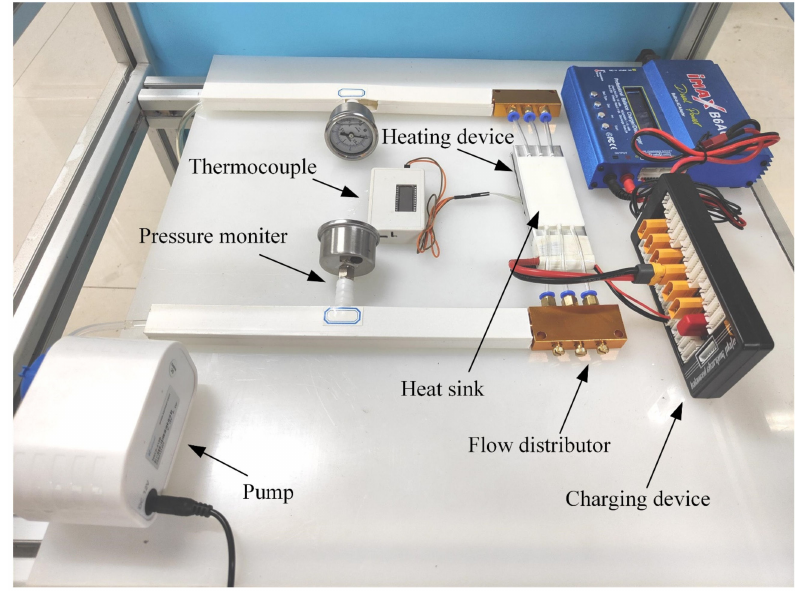
Figure 3. Experimental equipment